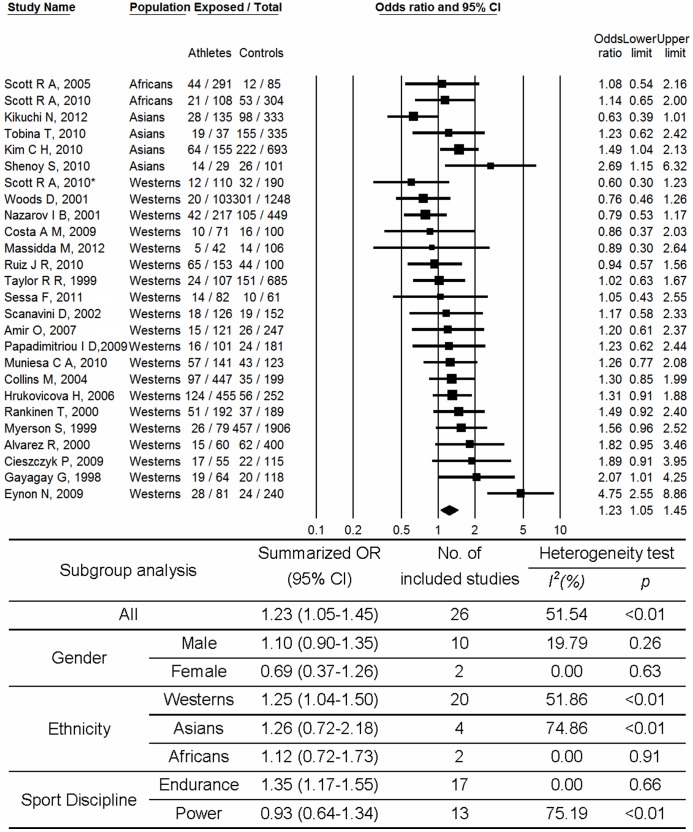
Meta-analysis of the association between sport performance and ACE polymorphism (II vs. ID+DD).Abbreviation: CI, confidence interval; OR, odds ratio. *Different study population from the same article.